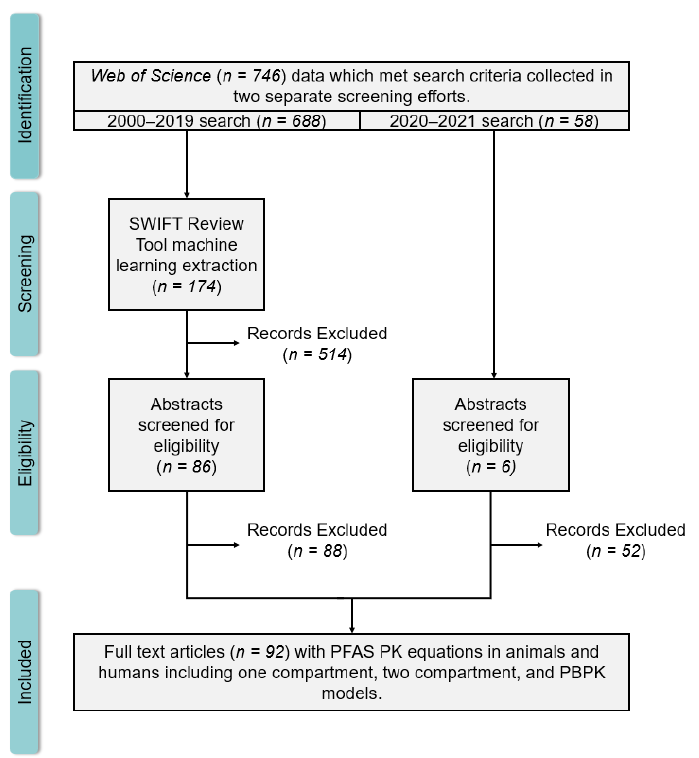
Figure 1. Identification, screening, eligibility, and inclusion of 2000–2019 and 2020–August 2021 PFAS TK WOS searches.